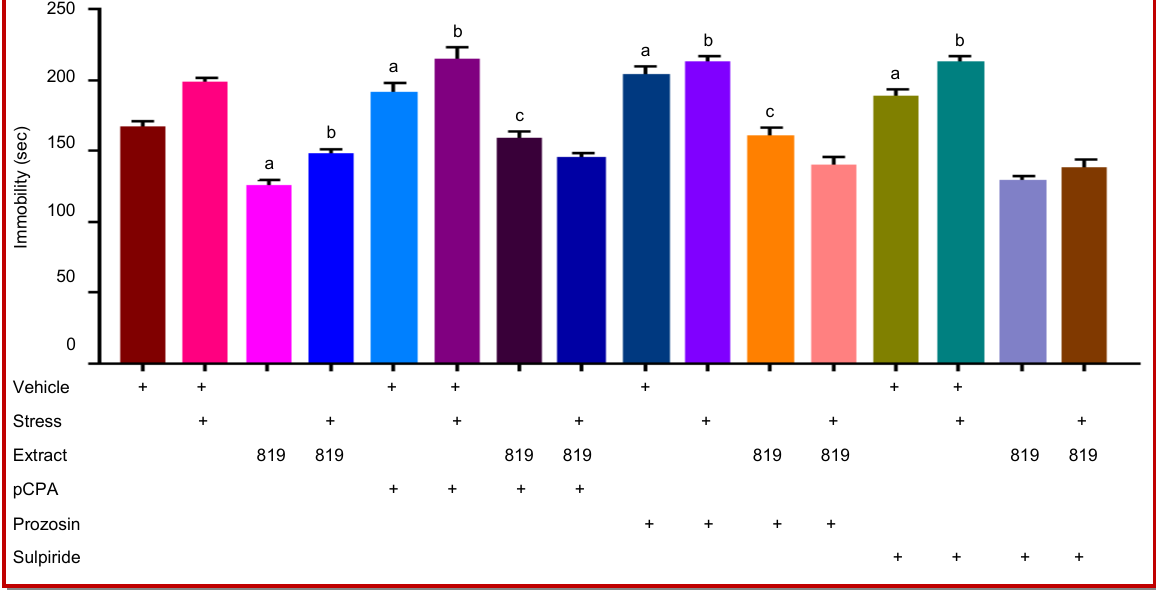
Figure 2: Effect of pCPA, prazosin and sulpiride per se and their combination with A. blazei on immobility periods of unstressed and stressed mice in TST. n=6 in each group. Values are expressed as the mean ± SEM. Data were analyzed by one- way ANOVA followed by Tukey’s test, except data for unstressed and stressed mice, which were analysed by Student’s unpaired t -test. a p<0.05, significant difference from vehicle-treated unstressed mice); b p<0.05, significant difference from immobilization-induced stressed mice; c p<0.05, significant difference from A. blazei (819 mg/kg)-treated stressed mice; d p<0.05, significant difference from aminoguanidine-treated stressed mice